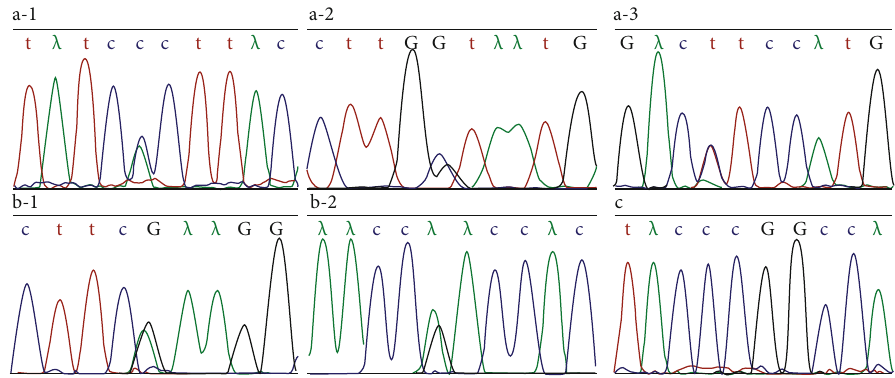
Figure 3: DNA sequencing results of proband I-1 (a-1, a-2, a-3), proband II-1 (b-1, b-2), and proband III-1 (c). In the proband I-1, a-1, a-2, and a-3 correspond to His54Pro, Leu1858Val, and 6531-12C > T of SPTA1 , respectively. In the proband II-1, b-1 and b-2 correspond to Arg344Gln and c.609+86G > A of SLC4A1, respectively. In the proband III-1, homozygous mutation Leu2032Pro is shown in